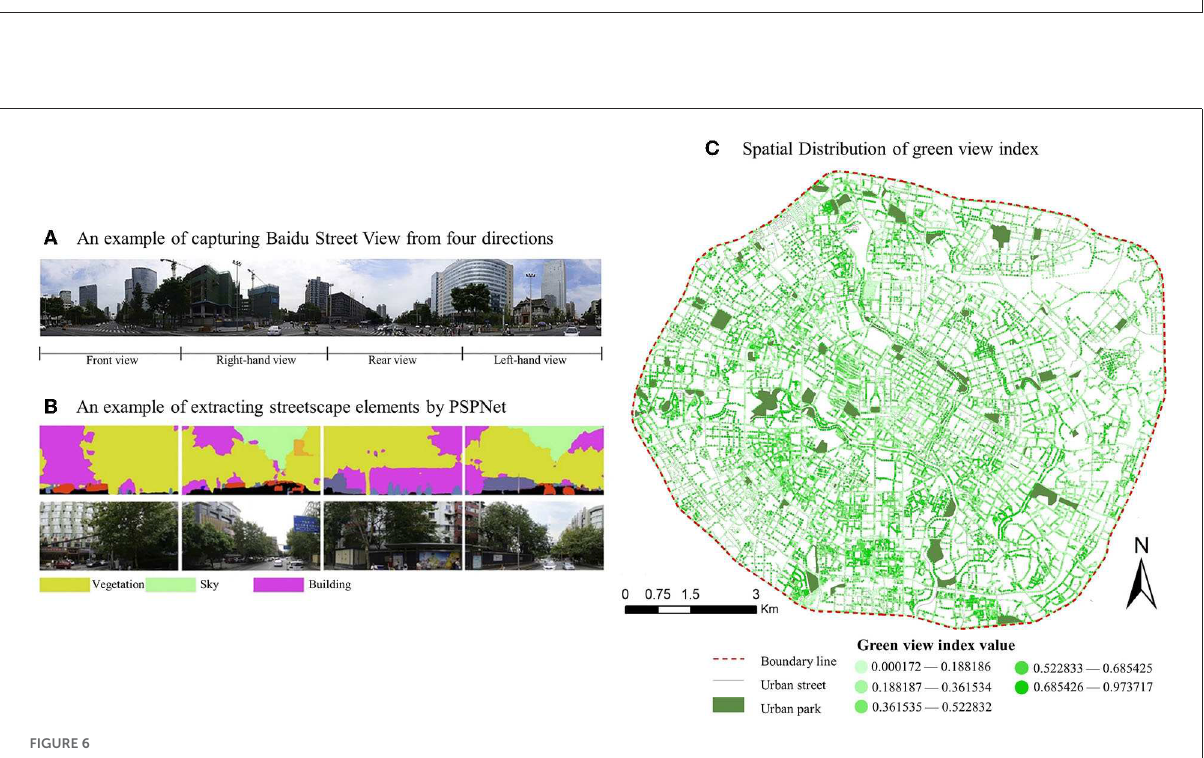
FIGURE6 Obtaining method and spatial distribution of green view